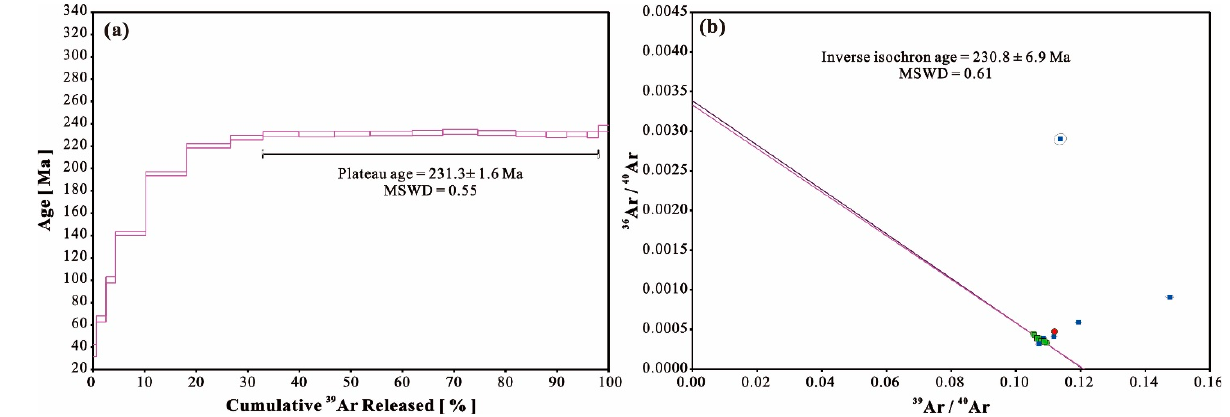
Figure 5. ( a ) Apparent age spectra and ( b ) inverse isochron diagram for biotite from the hornblende gabbro of the Baogeqi gabbro pluton obtained from 40 Ar/ 39 Ar step heating analyses.